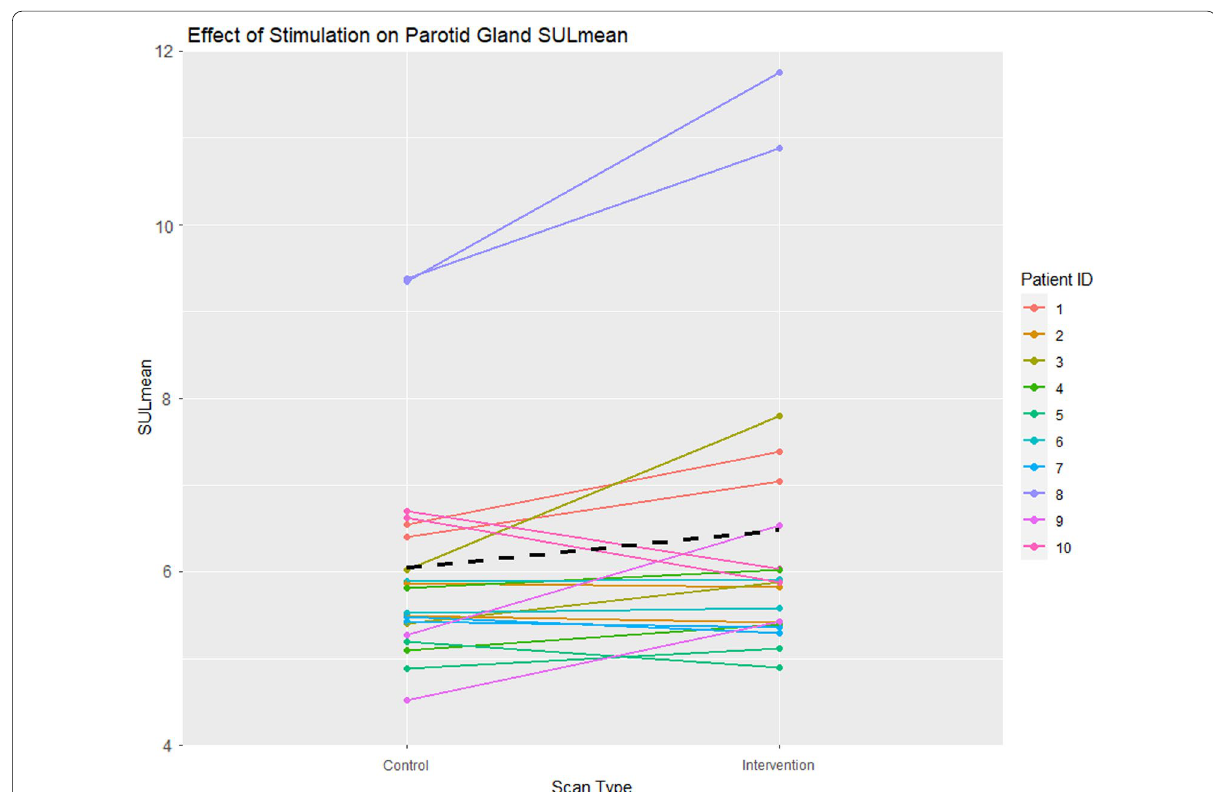
Fig. 2 Effect of gustatory stimulation on parotid gland SUL mean . Each patient is represented by a unique colour. The patients have two lines, one for the right parotid and one for the left parotid. The black dashed line depicts the overall population effect for all parotid glands of all